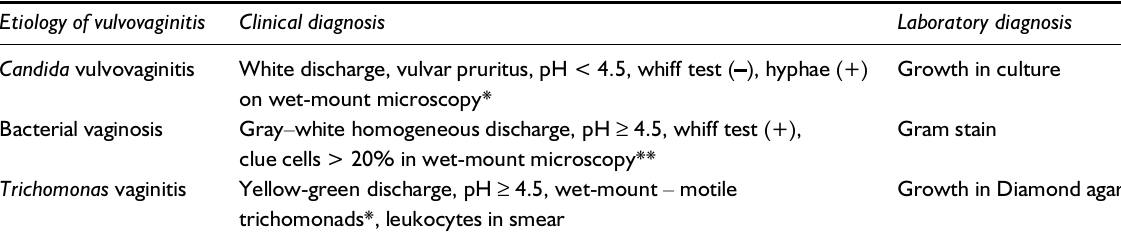
Table 1 Criteria of clinical and laboratory